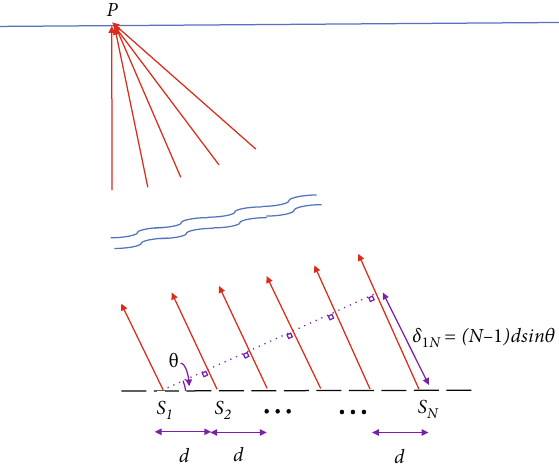
, S , S , ⋯ , S d units apart Figure 4: Rays from slits f S 1 2 3 n g spaced and convergent at a common point P on a distant screen can be considered as approximately parallel in the vicinity of the slits when the screen to slit-barrier distance is much greater than the interslit distance. The angle θ is as indicated and the path di ff erence between any pair of slits ð i , j Þ is given by the expression δ = ð j − i Þ d sin θ , where i < j . It follows that the phase di ff erence ij between adjacent slit pairs is α = ð 2 π / λ Þ d sin θ (reproduced from [25] ©IOP Publishing Ltd. CCBY